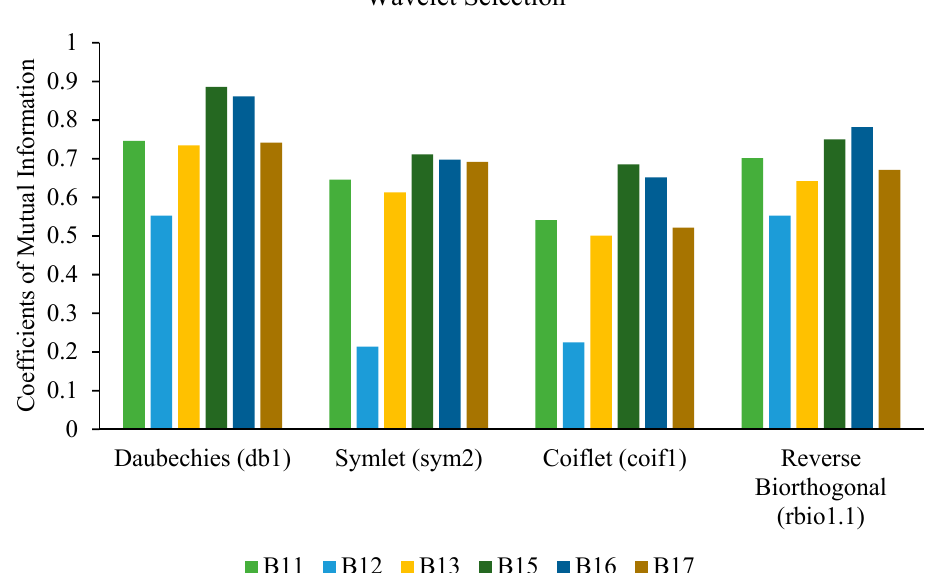
Figure 7. Wavelet selection based on mutual information.